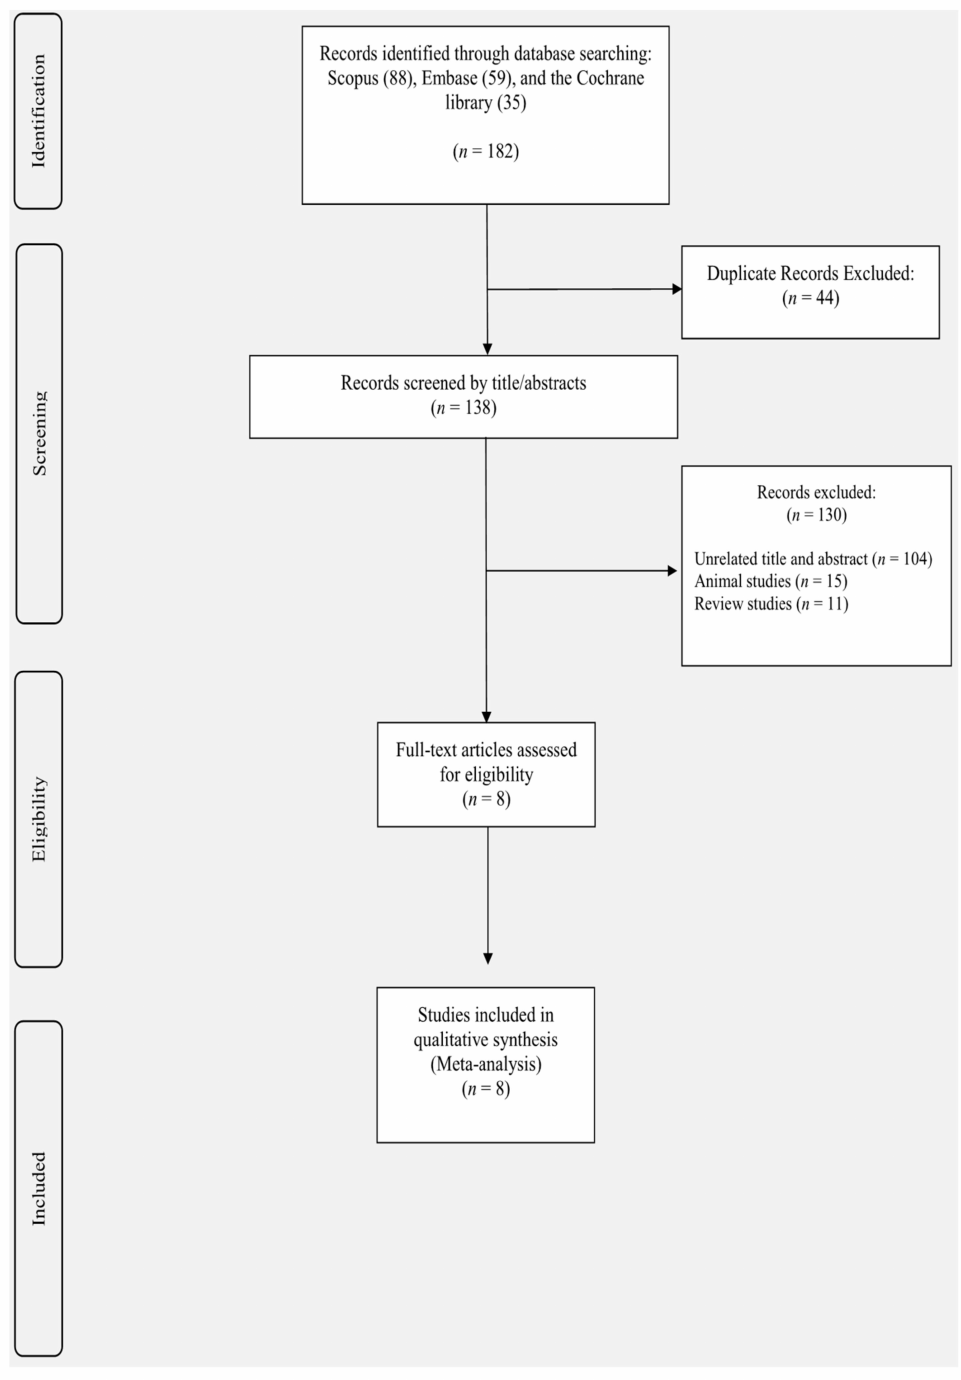
Figure 1. Flowchart of study selection for inclusion of